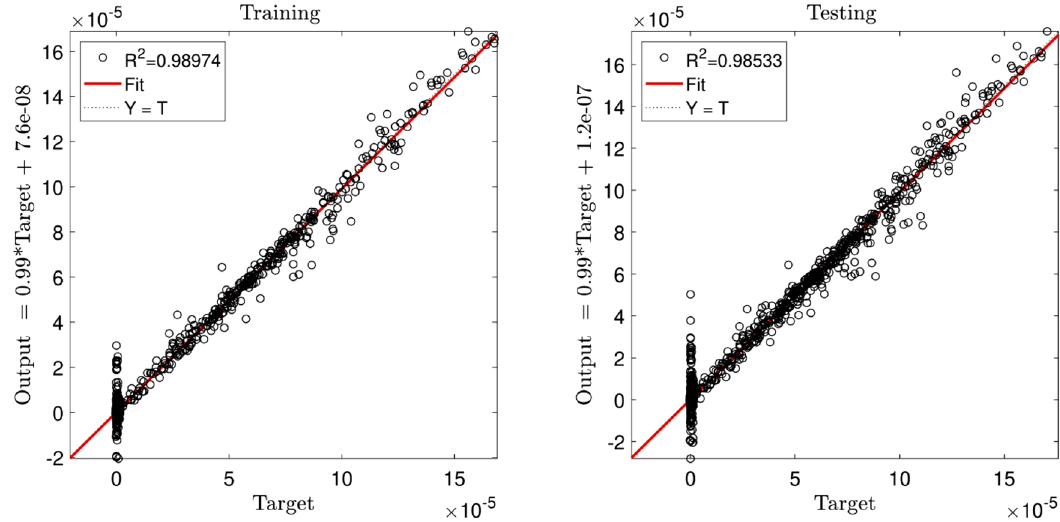
Figure 6. Coefficient of determination in the best DEFIS intelligence.